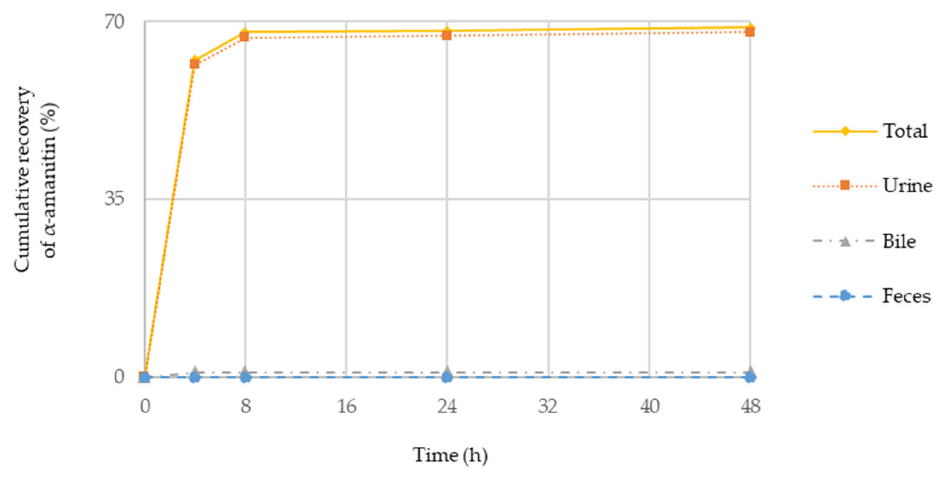
Figure 5. Cumulative recovery of α -amanitin in urine, bile, and feces after IV administration.